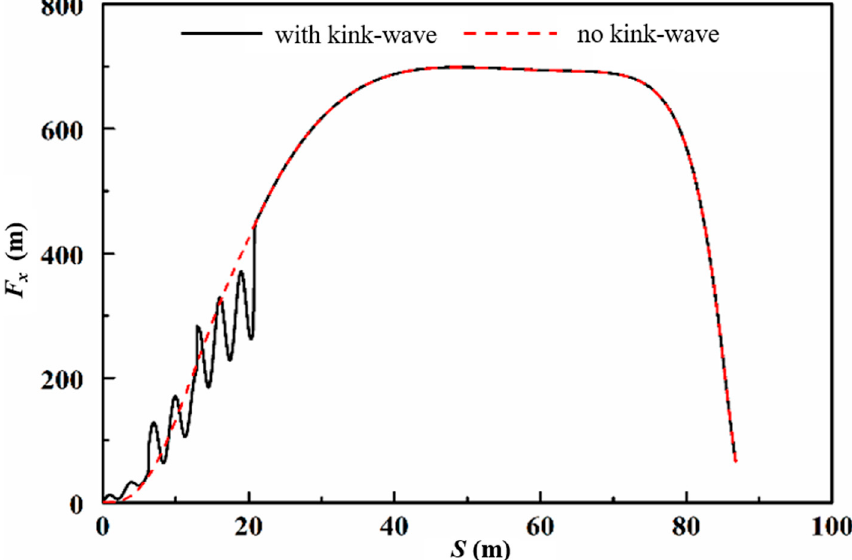
Figure 8. Curve of arresting force–displacement in centering arrest.